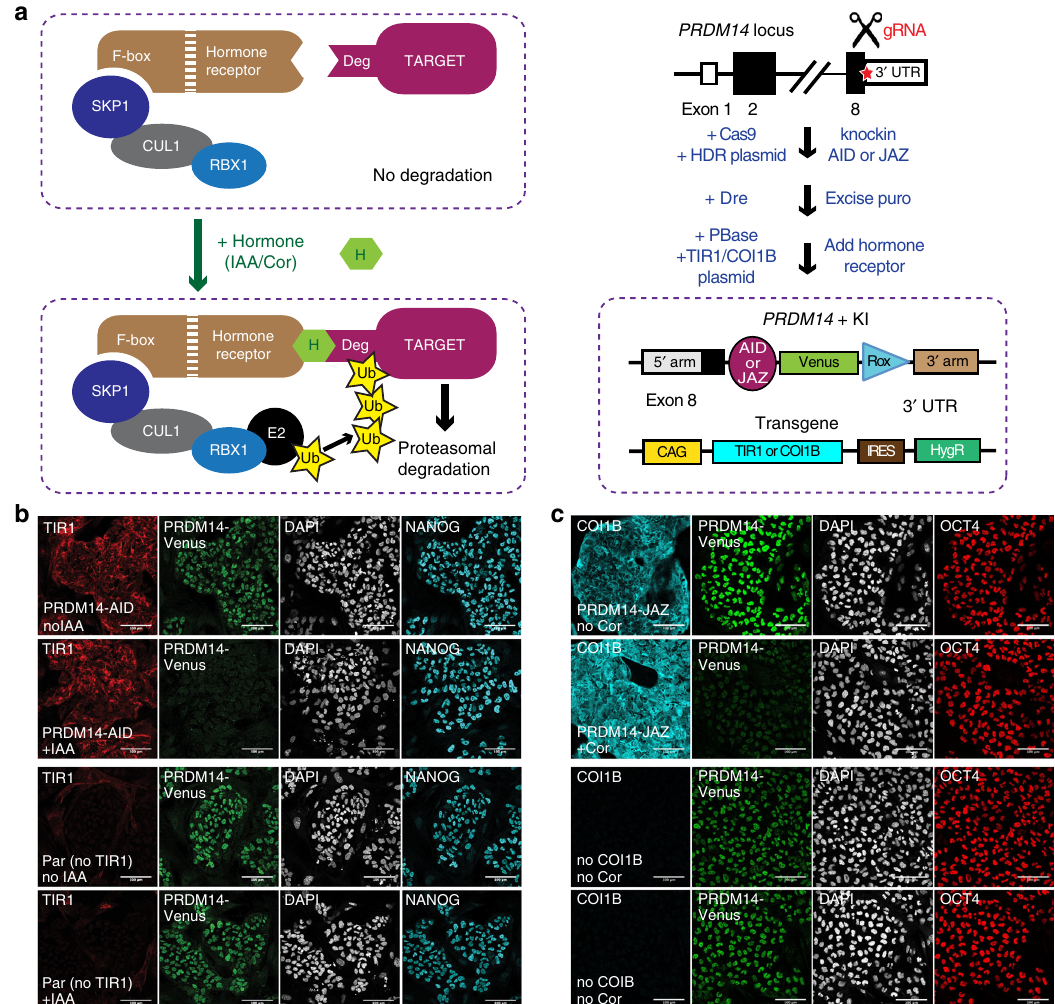
Fig. 3 Auxin- and jasmonate-inducible degrons allow fast and homogenous PRDM14 protein depletion. a Scheme of AID and JAZ systems and the derivation of PRDM14-AID-Venus and PRDM14-JAZ-Venus cell lines. SKP1, CUL1, RBX1 and F-box (TIR1 or COI1B) are the subunits of the SCF E3 ubiquitin – ligase complex. In the presence of IAA (for AID) or Cor (for JAZ) the target associates with the E3 ligase via a cognate hormone receptor (F-box protein); the recruited E2 ubiquitin-conjugating enzyme polyubiquitinates the target, which results in its proteasomal degradation 24,80 . For cell line generation, the cells were fi rst transfected with two plasmids: (1) Cas9-encoding plasmid 25 with a gRNA sequence targeting the vicinity of the PRDM14 stop codon; (2) HDR (homology-directed repair) template (also see Fig. 1a) containing the sequences to be appended by KI, fl anked by two 800-bp homology arms; MC1-DTA was added to reduce random integration 5 . The knocked-in sequences were: AID ( At AID 44 ) or JAZ ( Os JAZ 43 ) followed by Venus and a positive/negative PGK-puromycin- Δ TK selection cassette fl anked by Rox sites to allow excision by Dre 5 . Correct homozygous clones were transfected with PiggyBac constructs encoding the corresponding hormone receptor (TIR1 for AID and Fb-TIR1-COI1B for JAZ) under the control of the CAG promoter followed by an IRES and a hygromycin resistance gene. The homogeneity of myc-TIR1 or HA-COI1B expression in selected clones was checked by IF (see b , c ). b IF (representative of three experiments) showing PRDM14, NANOG and TIR1 (myc-tagged) expression and PRDM14-AID-Venus depletion upon 25 min of IAA treatment. Nuclei were counterstained by DAPI. Scale bar is 100 μ m. c IF (representative of three experiments) showing PRDM14-Venus, OCT4 and COI1B (HA-tagged) expression and PRDM14-JAZ-Venus depletion upon 2 days of Cor treatment. Nuclei were counterstained by DAPI. Scale bar is 100 μ